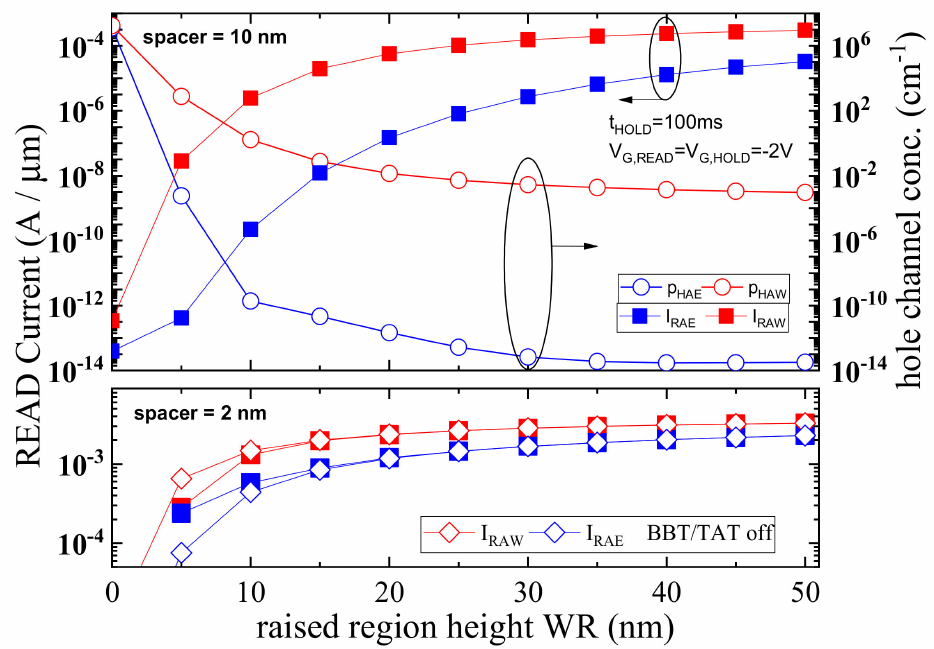
Figure 8. ( Top-left axis ) RAW and RAE currents and ( Top-right axis ) integrated hole concentration in the channel region ( − L /2 ≤ x ≤ L /2, y ≥ 0) during HAW and HAE as function of the raised region height (WR). At the bottom are shown the RAW and RAE currents with BBT and Trap-Assisted- Tunneling (TAT) models turned on (filled symbols) and off (empty symbols) in a geometry with L SP = 2 nm.